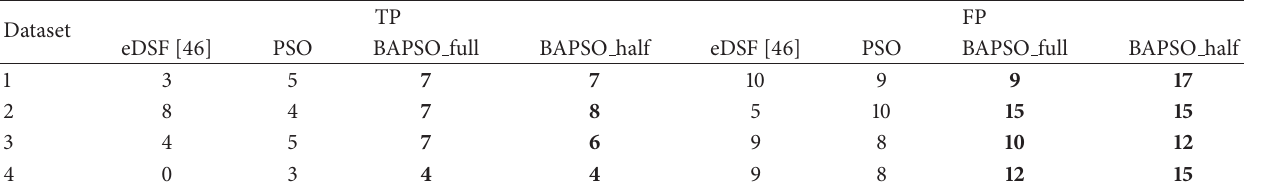
Table 3: Comparison of results obtained from the E. coli experiments with [46].